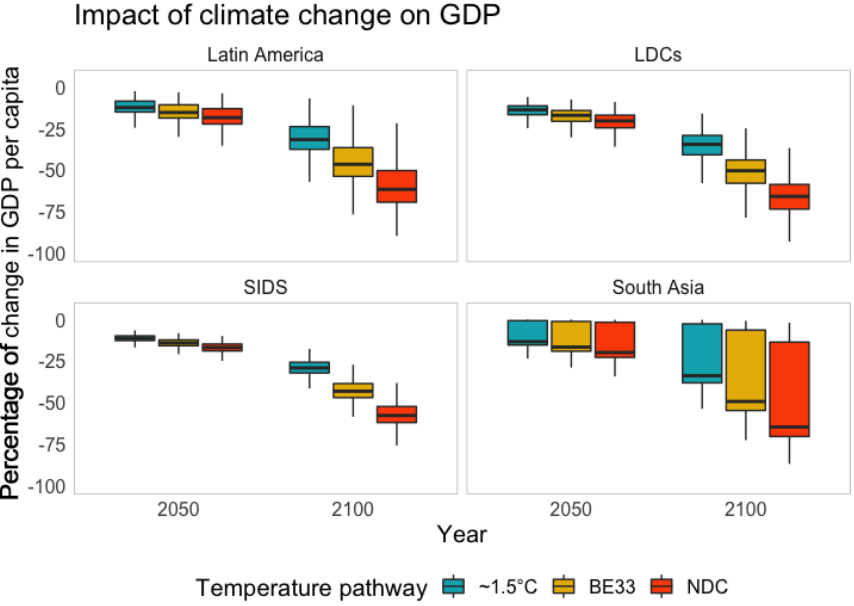
Figure 4. Economic damages under different scenarios of GMT increase. The boxplots contain estimates for different GCMs, and show the percentage difference between GDP per capita under selected temperature pathways (no change in current NDCs, BE33 scenario resembling a 33% change in NDCs of big emitters and a 1.5 ◦ C pathway) and GDP per capita under a no-climate-change scenario. The lower and upper hinges correspond to the first and third quartiles (the 25th and 75th percentiles). The upper whisker extends from the hinge to the highest value that is within 1.5 times the interquartile range of the hinge. Estimates are given for mid century (2046–2065) and end of century (2081–2100). Countries are grouped by either geographical regions (South Asia and Latin America) or political groupings following the UN classifications (Small Island Development States, SIDS, and Least Developed Countries,